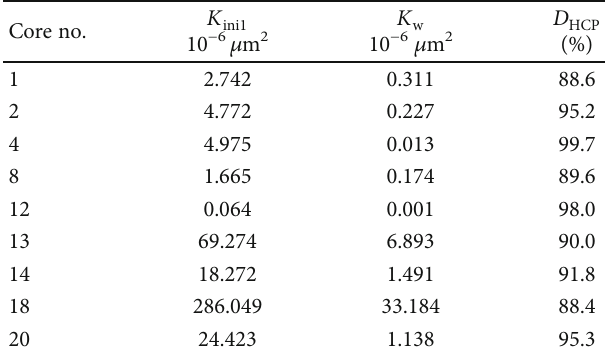
Table 3: HCP damage test results of the tight sandstone cores.